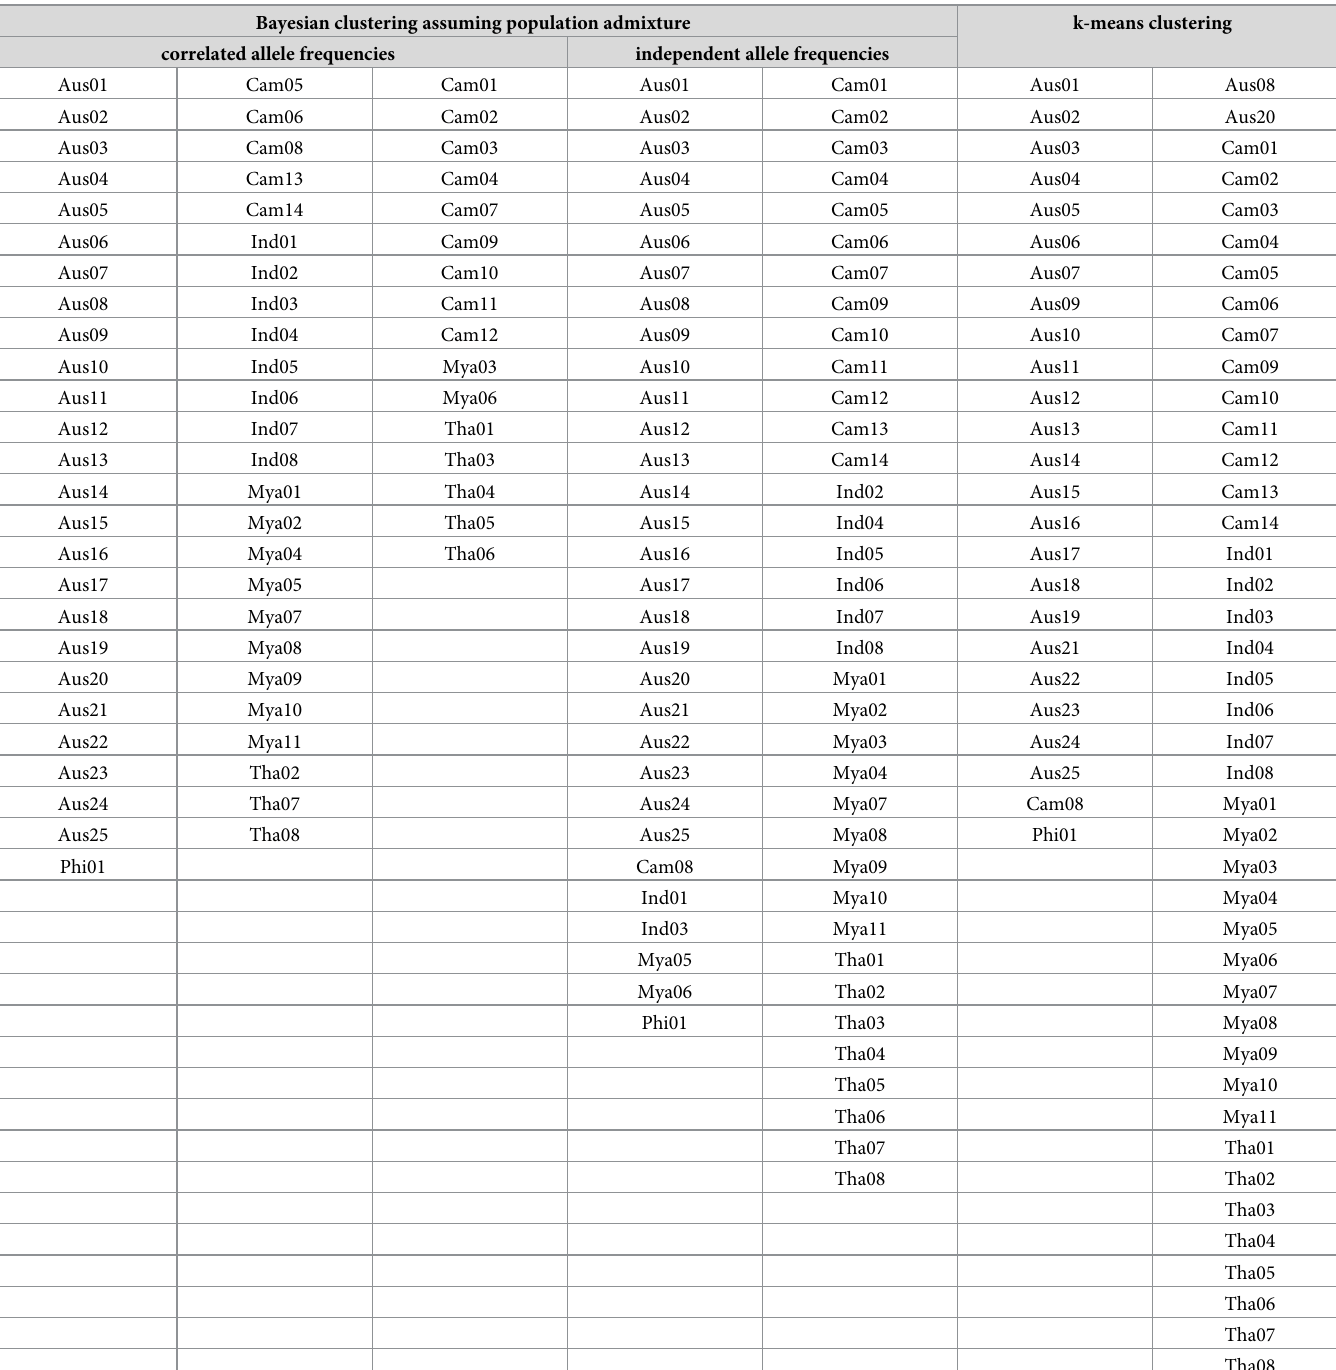
Table 4. Cluster analyses (codes from Table 2